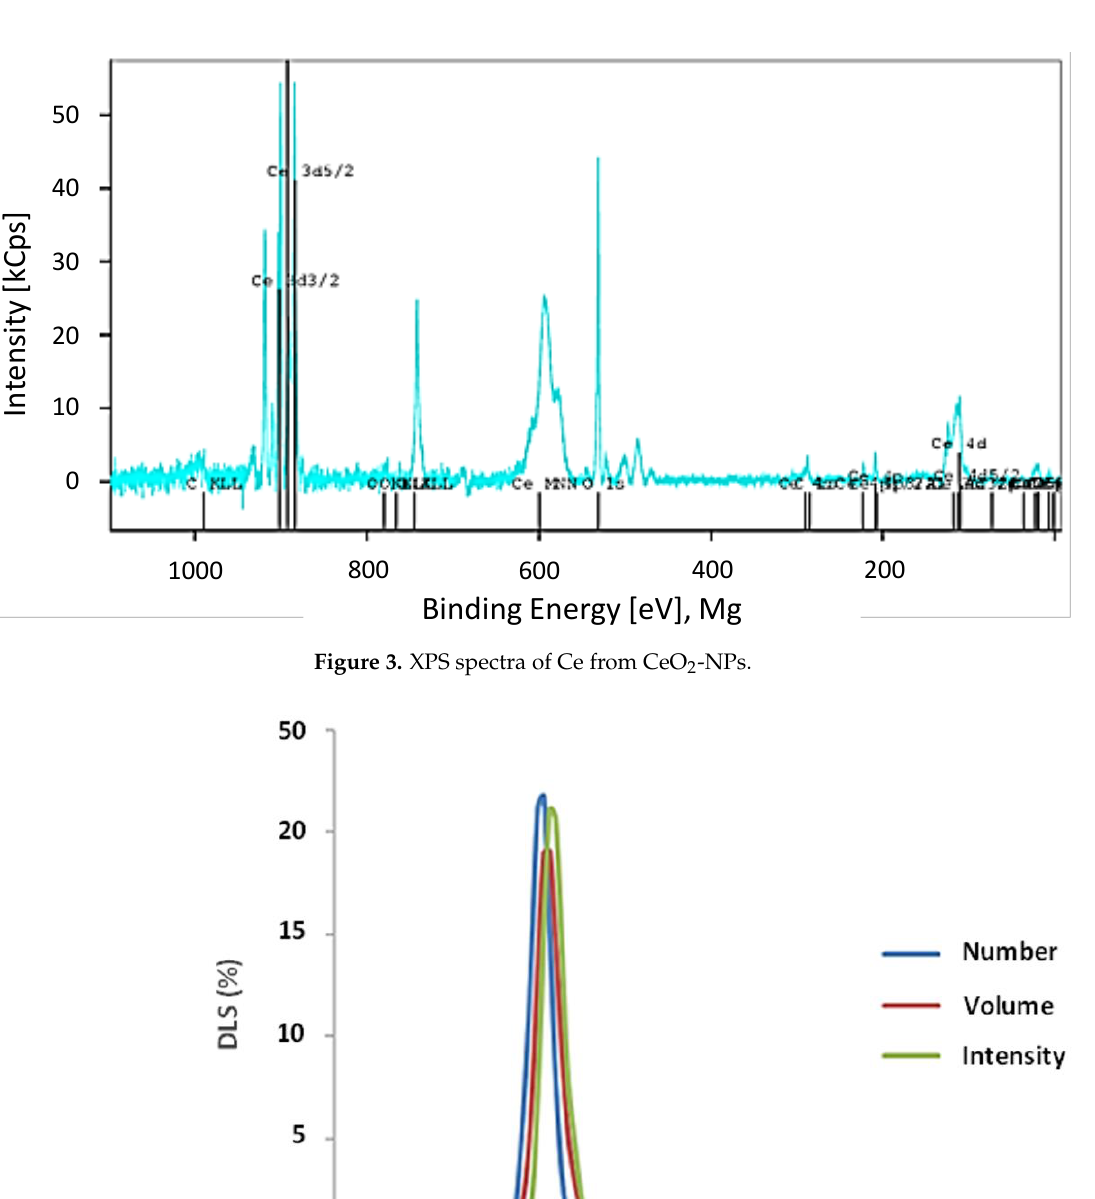
Figure 4. Hydrodynamic size distribution of CeO 2 -NPs suspended in water.